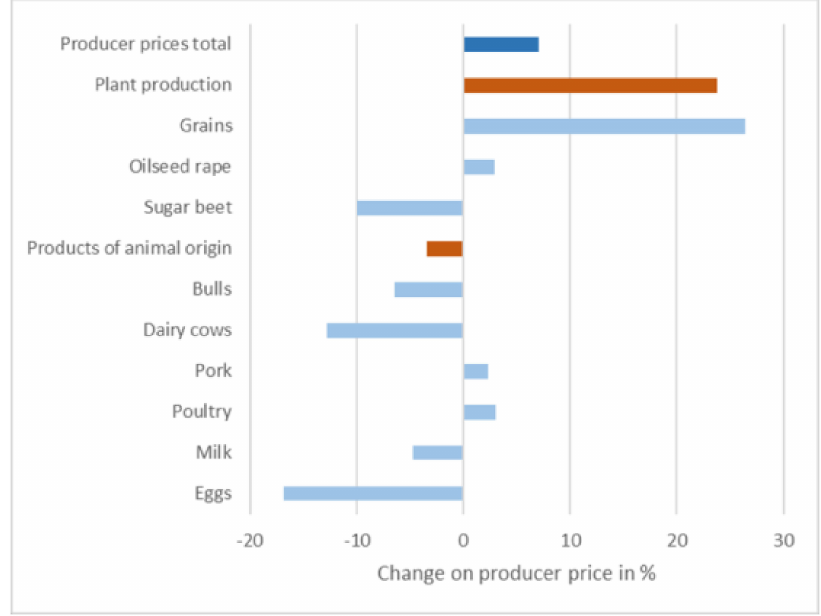
Figure 6. Development of producer prices in agriculture between January 2018 to January 2019 [52] (source: [52], adapted and